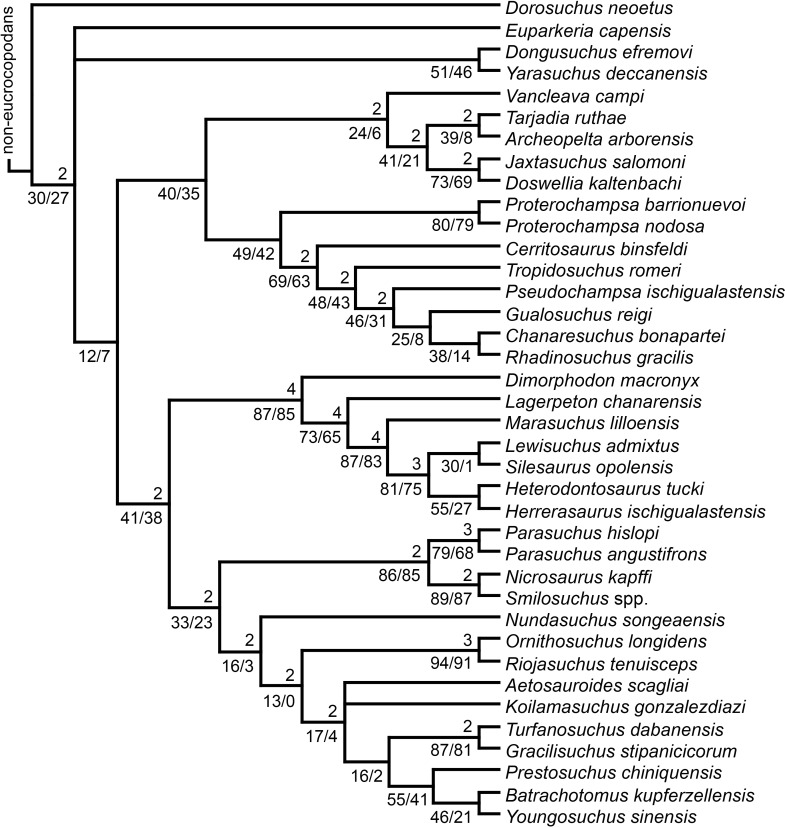
Branch support values shown on the strict reduced consensus tree recovered from analysis 3 after the a posteriori pruning of Kalisuchus rewanensis and Asperoris mnyama.Numbers above internal branches are Bremer supports above 1 and numbers below internal branches are absolute (left) and GC (right) bootstrap frequencies. Non-eucrocopodan diapsids are not skown in this tree.